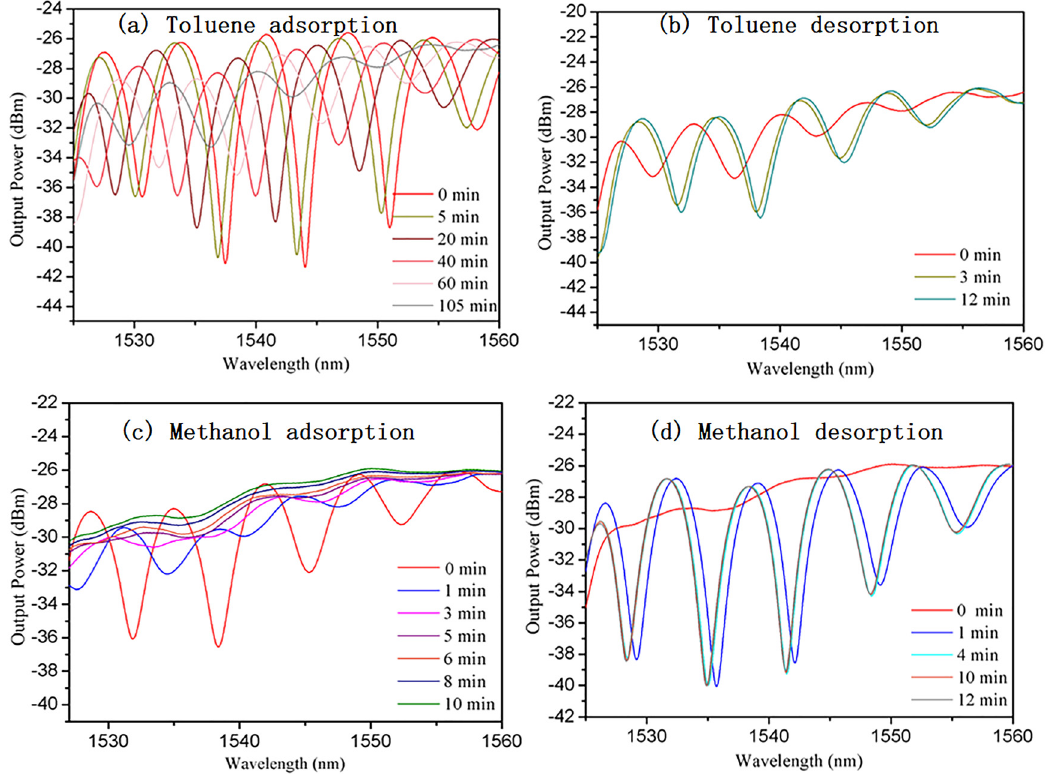
Figure 8: Real-time spectral change of fiber Mach – Zehnder interferometer (MZI) in monitoring the adsorption and desorption of